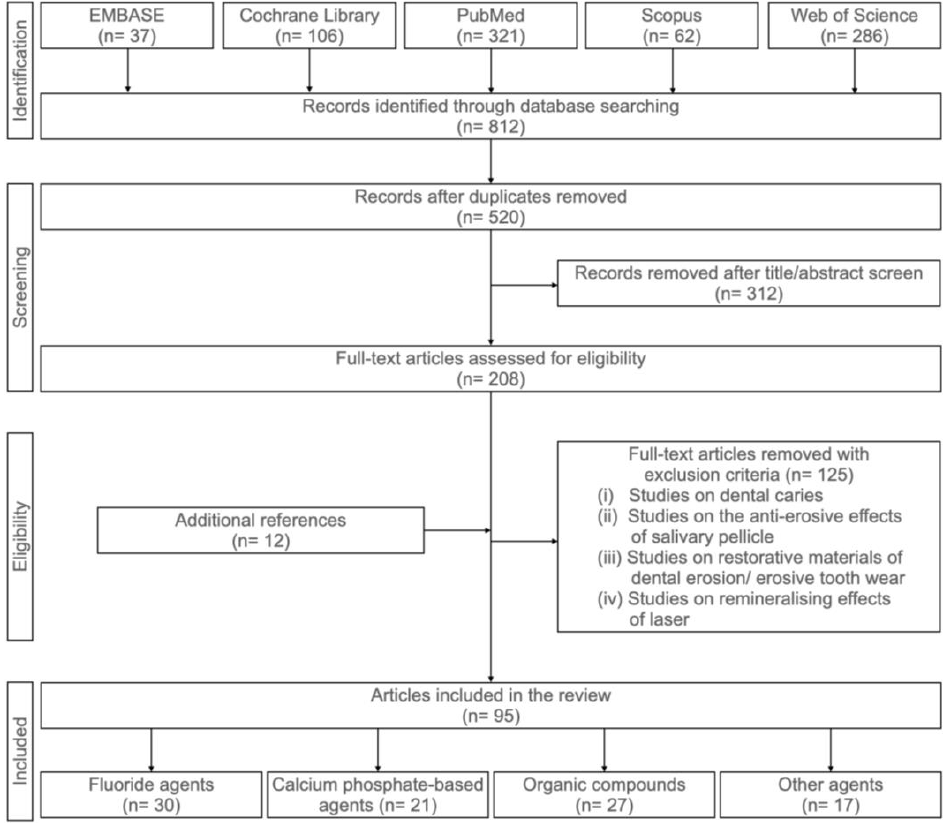
Figure 1. Flowchart summarising the reference-selection process.